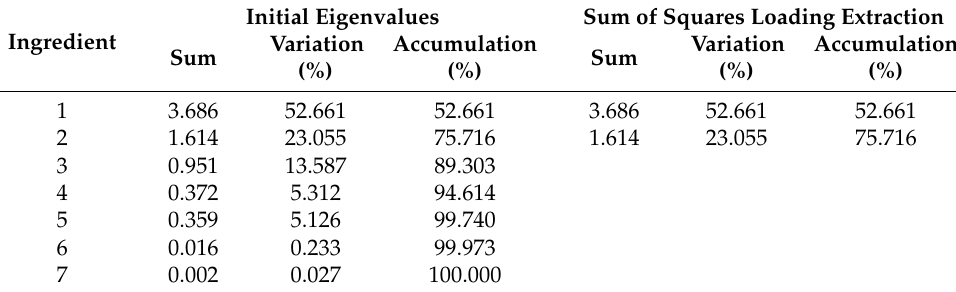
Table 9. Total variation interpretation, principal component